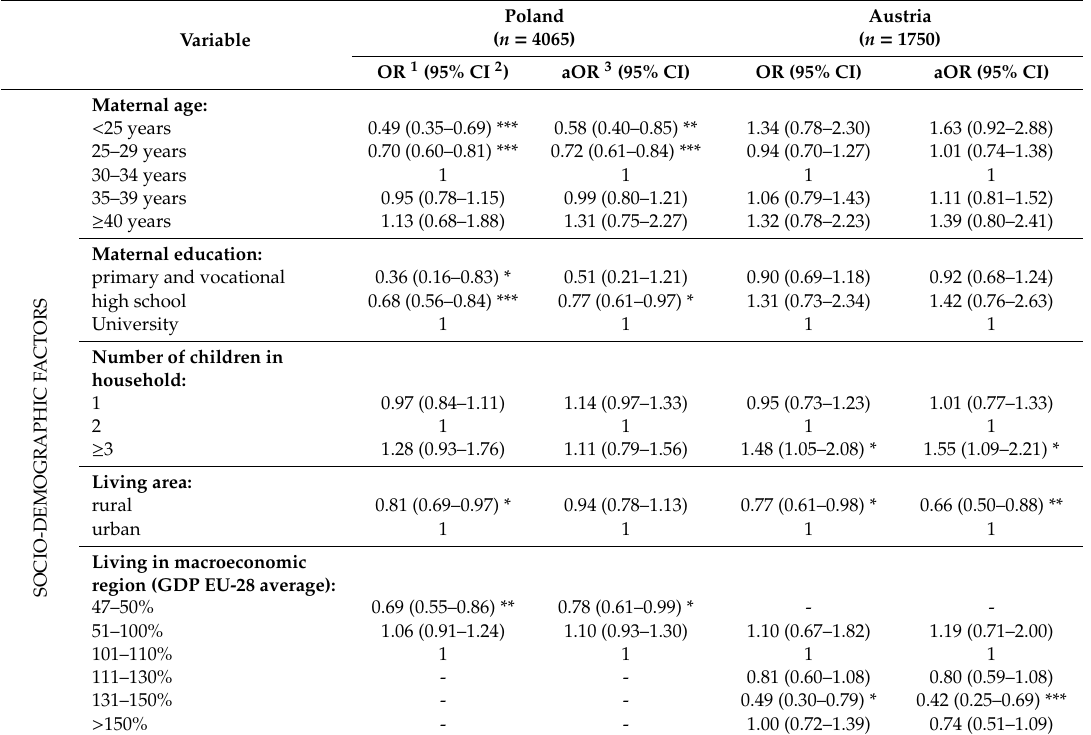
Univariate and multivariate regression analysis models of factors influencing the complementary feeding introduction after 6 completed